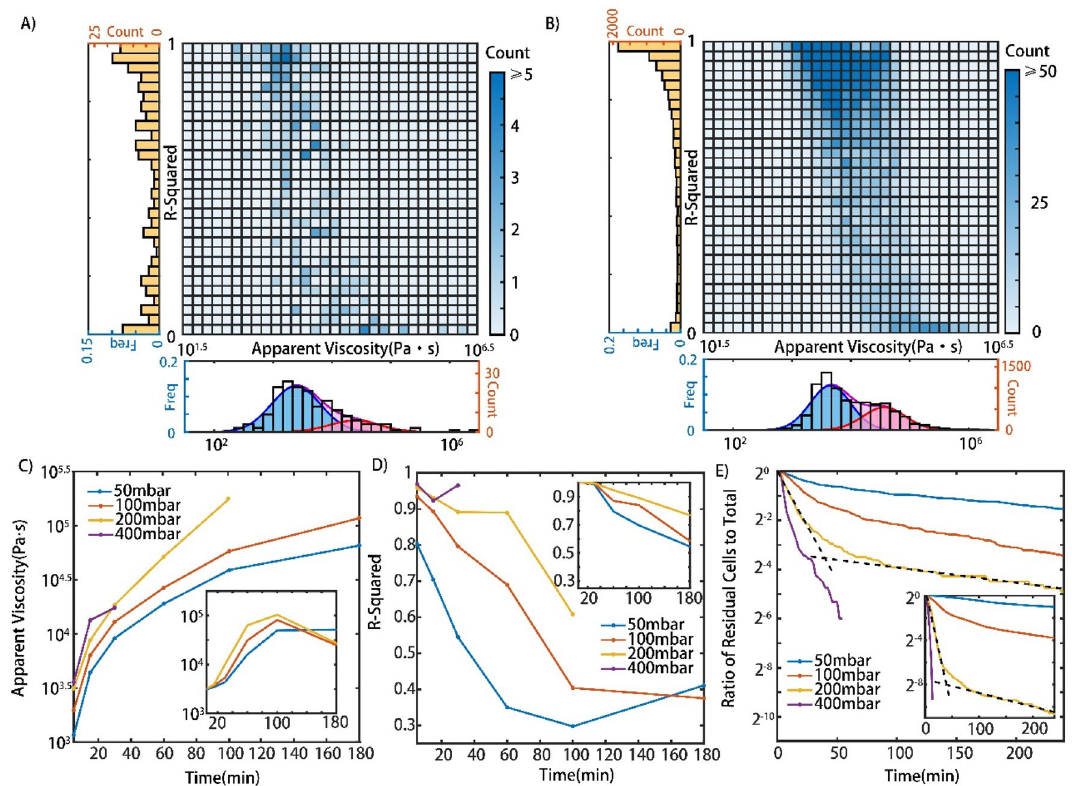
Figure 5. ( A , B ) Heatmap depicting the number of cells with corresponding R-squared and apparent viscosities under the pressure difference 50 mbar. ( A ) Counts cells between 20 and 40 min in experiments. ( B ) Counts cells between 40 and 80 min in simulations. ( C , D ) Medians of apparent viscosities and R-squared of cells (up to 400 cells in the first time frame under the pressure difference 50 mbar, no less than 20 cells in the final time frame under the pressure difference 400 mbar) over time under different pressure differences in experiments. Insets are in simulations. ( E ) Ratio of residual cells (larger than 200 cells in any condition at the start of experiments) to total throughout the experiments under different pressure differences. Inset is in simulations. Dashed lines represent results of linear fitting for two distinct